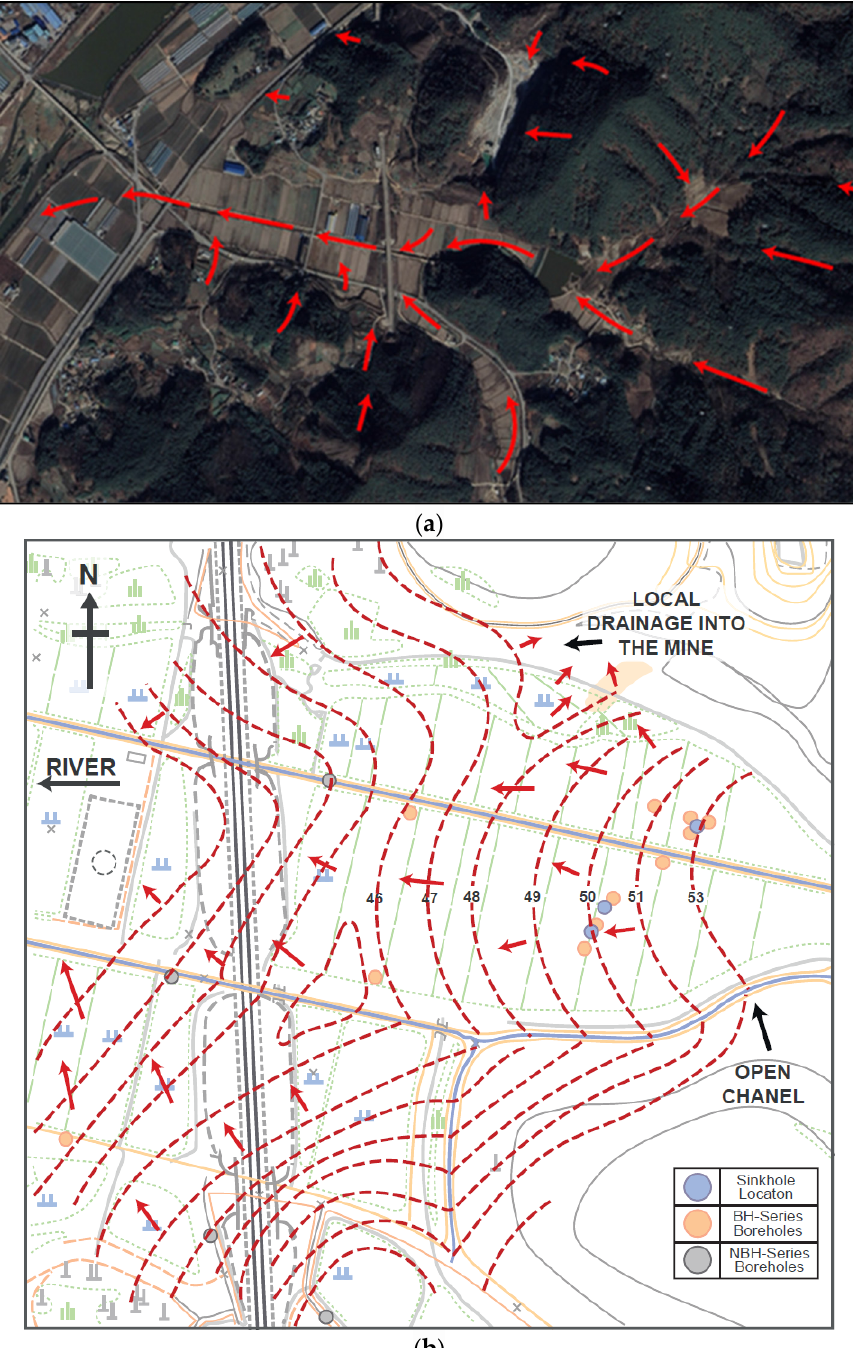
Figure 26. ( a ) Groundwater flow direction towards Hwangnyong river. Note the minor local inflow in the mine. There is no indication of any soil leaching, ( b ) interpreted groundwater flow direction-based groundwater contours. For base map information, see Figure 14.